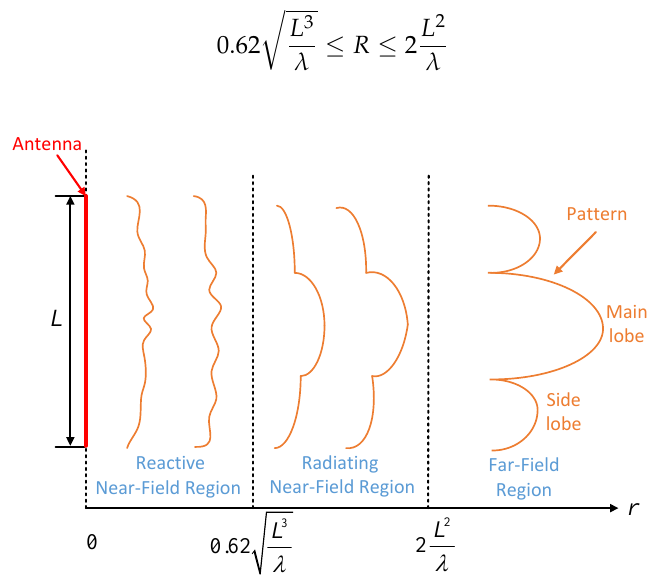
Figure 3. Far-field and near-field region.